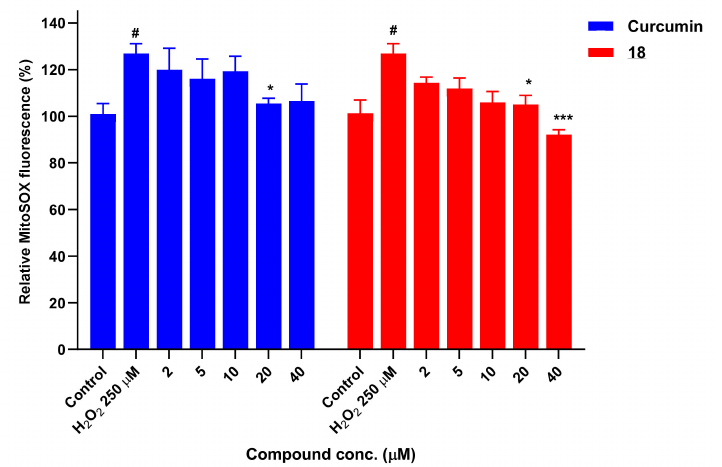
Figure 19. Reduction in mitochondrial superoxide levels by 18 and curcumin in SH-SY5Y. Cells were treated with 18 and curcumin for 24 h prior to exposure to H 2 O 2 . ROS levels were evaluated with MitoSox. Data are presented as the Mean ± SEM of three independent experiments carried out in quadruplicate. # p < 0.001 vs. vehicle-treated control. * p < 0.05, *** p < 0.001 vs. only with H 2 O 2 -treated cells. Figure S4 (Supplementary Materials) shows microscopy images from MitoSOX experiments performed with compound 18